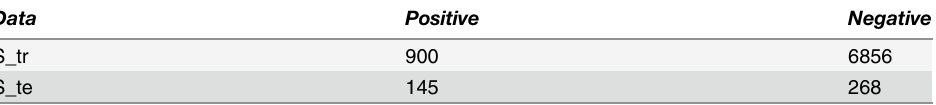
Table 1. The number of positive and negative peptides in training and independent test dataset.